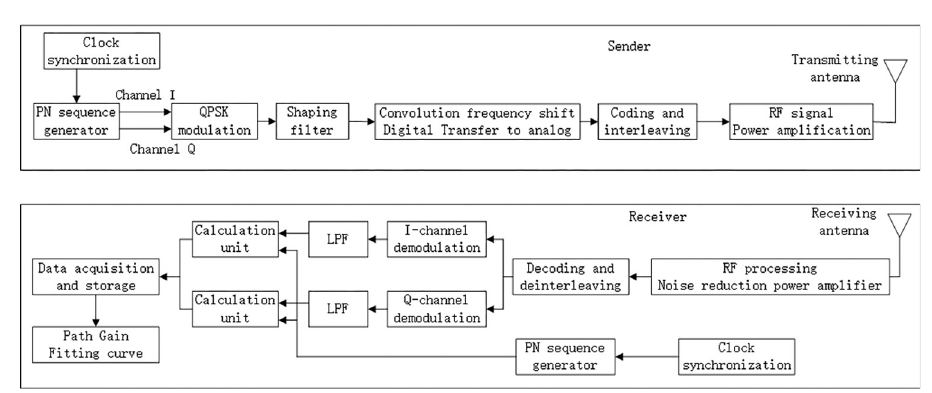
Fig 6. Measurement principle and method of self-built